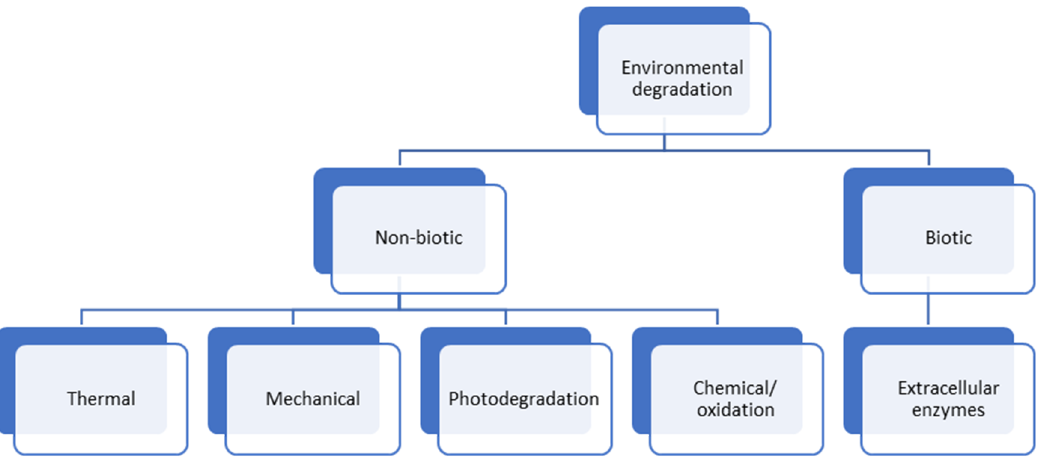
Figure 3. Environmental degradation affects plastic